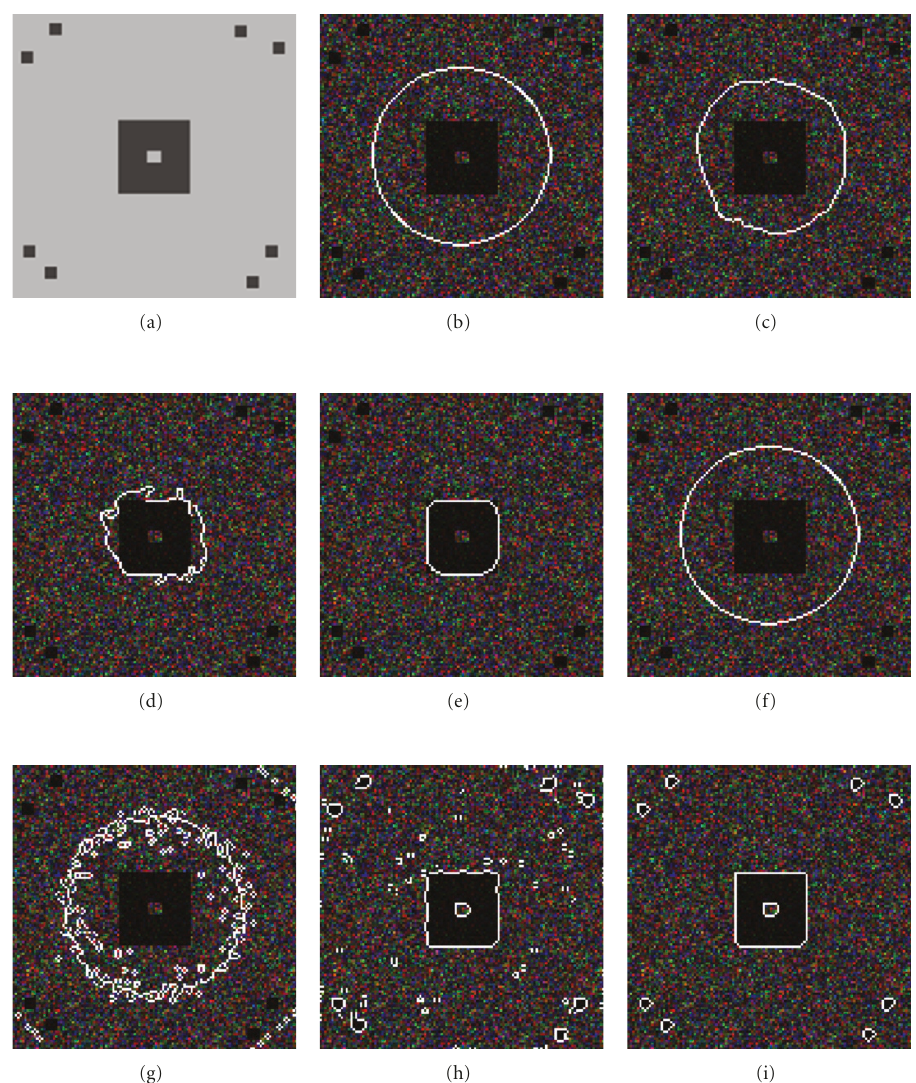
Figure 1: Comparison of single-look synthetic data object segmentation. (a) Ideal segmentation, size: 120 × 120. (b)–(e) Segmentation by the method in [10]. (f)–(i) Segmentation using our method with global stationary minimum, μ = 3 . 6, α =